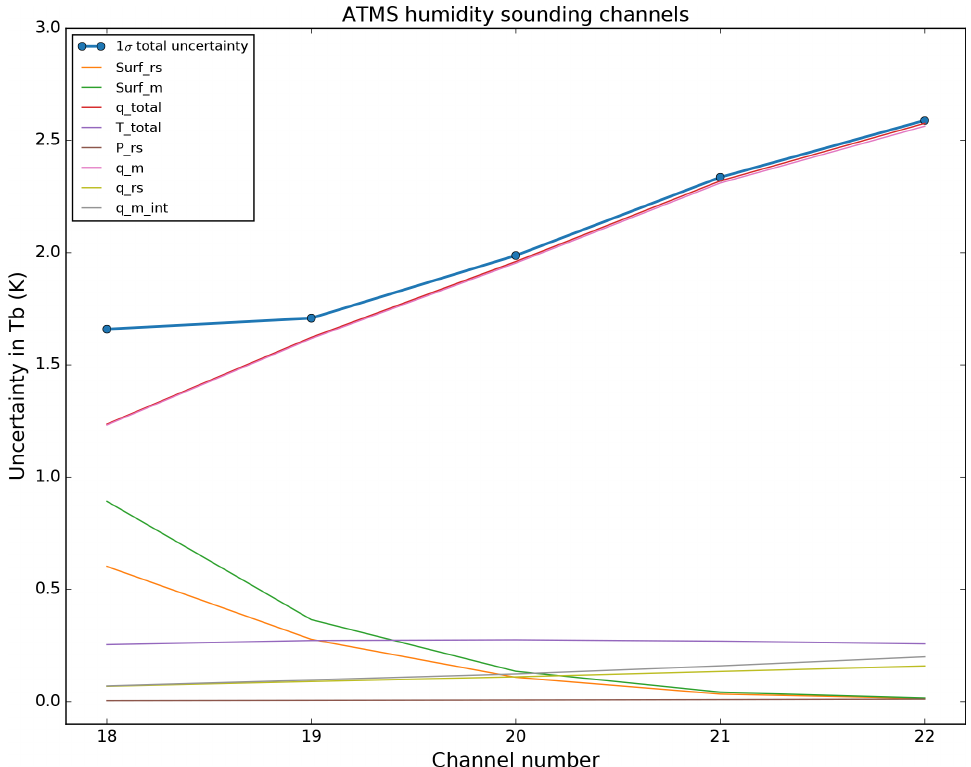
Figure 8. Same as Fig. 6 but only for ATMS humidity tropospheric channels 18–22, with the square root of the diagonal of the components forming S q_total , namely, the GRUAN humidity uncertainty (q_rs, olive), the model humidity uncertainty (q_m, pink), and the model vertical interpolation uncertainty (q_m_int,